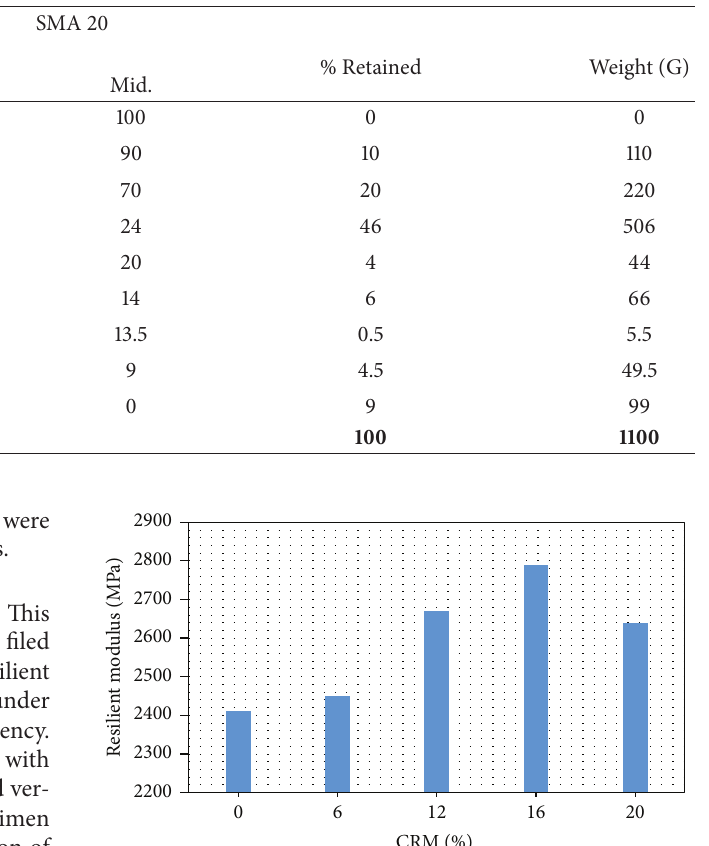
Table 3: SMA 20 aggregate gradation [9].